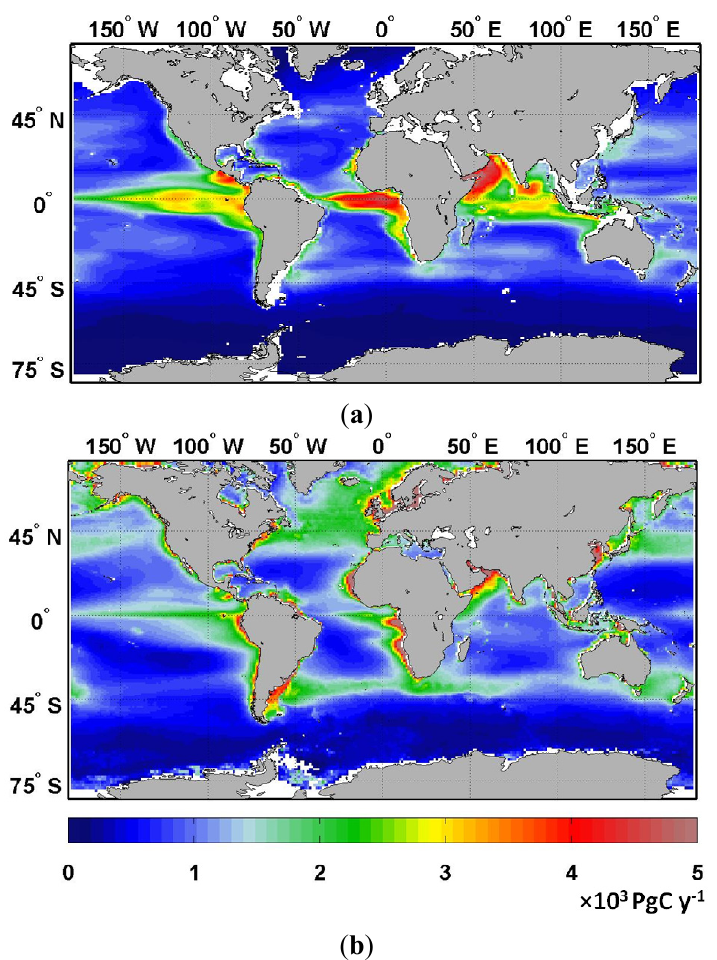
Figure 2. Climatological map of primary production for ( a ) NOBM and ( b ) VGPM for the period from 1998 to